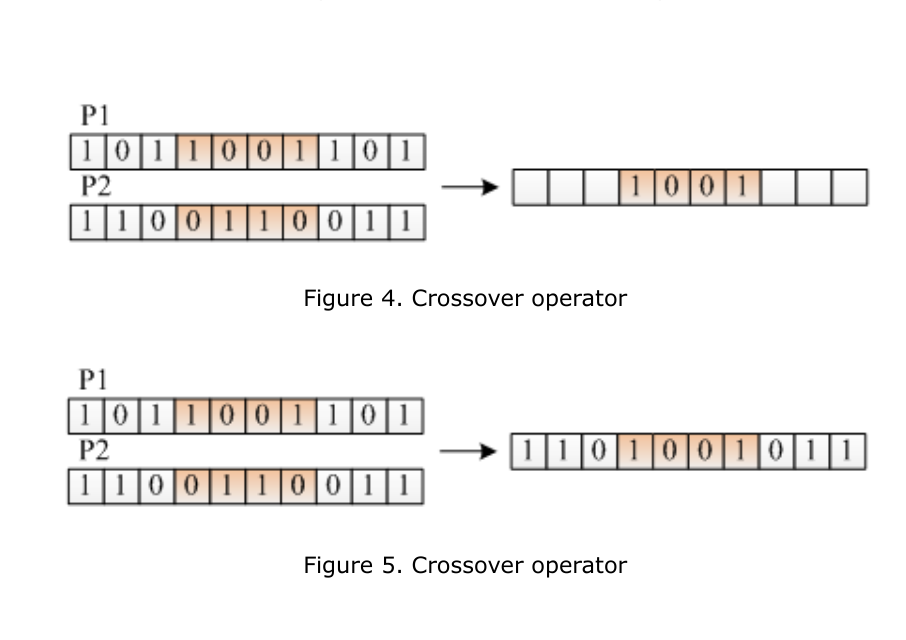
Figure 4. Crossover operator